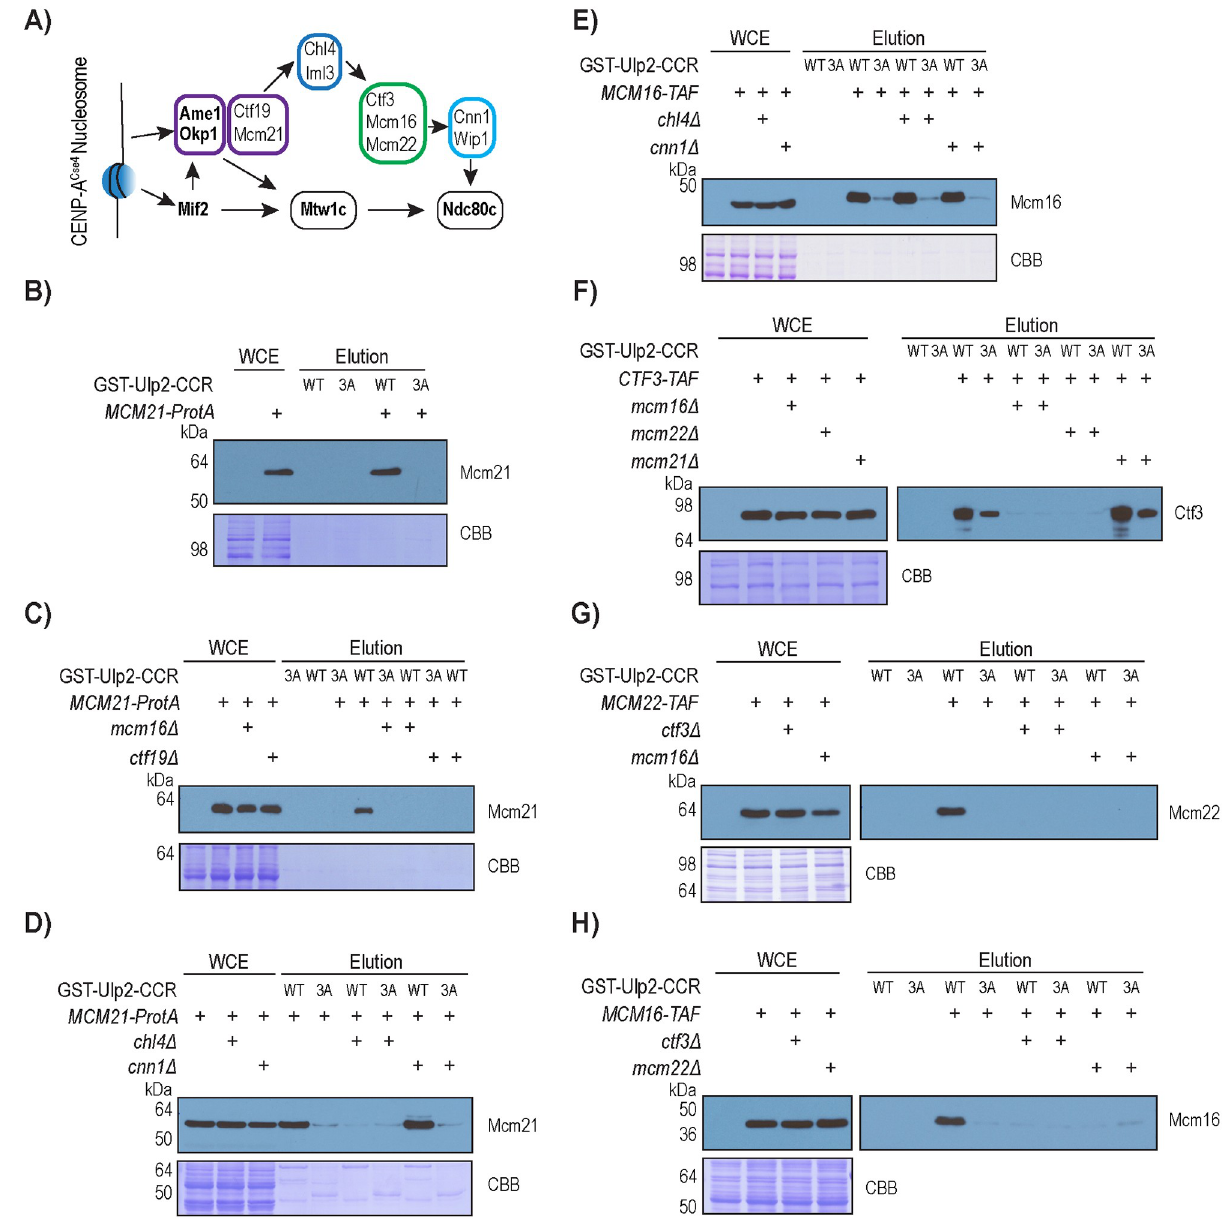
Fig 3. Binding between Ulp2’s CCR and the kinetochore requires the Ctf3-Mcm16-Mcm22 complex. A) Illustration of the hierarchical order of CCAN assembly. Various sub-complexes of CCAN are distinguished in colored boxes, in which essential subunits are shown in bold . B) Pull-down assay to observe the binding between Mcm21 and Ulp2’s CCR. C) Effect of mcm16 Δ and ctf19 Δ on the binding between Mcm21 and Ulp2’s CCR. D) Effect of chl4 Δ and cnn1 Δ on the binding between Mcm21 and Ulp2’s CCR. E) Effect of chl4 Δ and cnn1 Δ on the binding between Mcm16 Ulp2’s CCR. F) Effect of mcm16 Δ , mcm22 Δ and mcm21 Δ on the binding between Ctf3 and Ulp2’s CCR. G) Effect of mcm16 Δ and ctf3 Δ on the binding between Mcm22 and Ulp2’s CCR. H) Effect of mcm22 Δ and ctf3 Δ on the binding between Mcm16 and Ulp2’s CCR. TAF tag refers to 6xHIS-3xFLAG-ProteinA (see footnote in S12